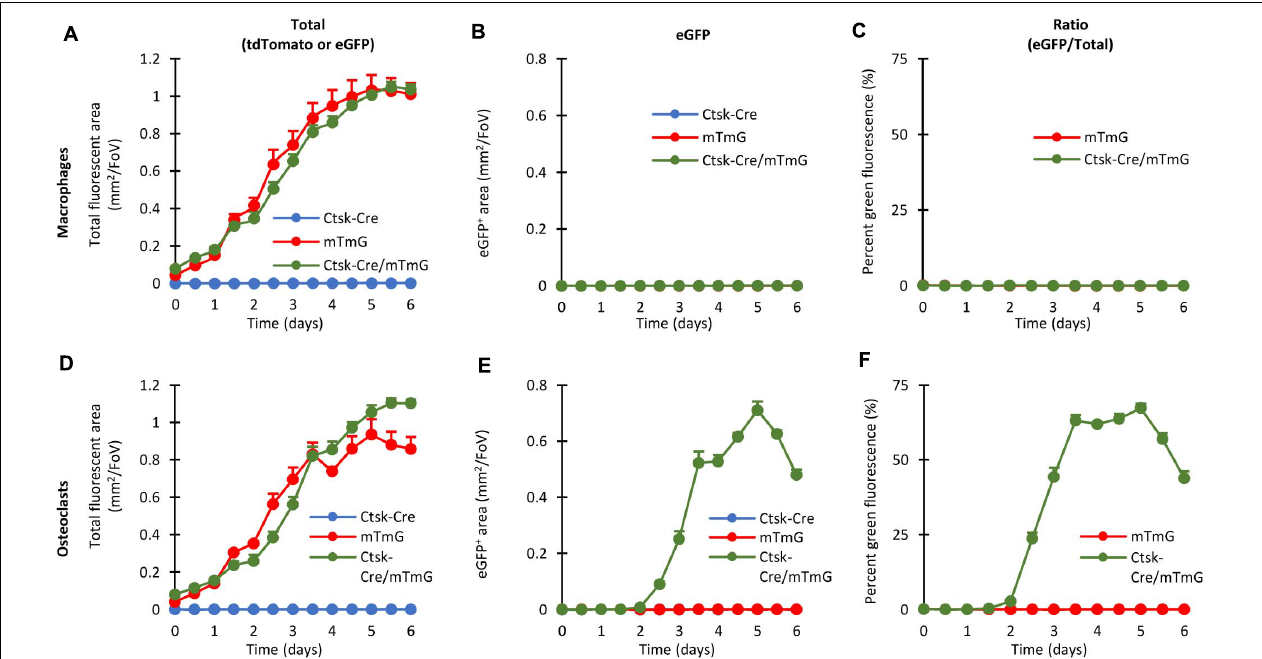
FIGURE 4 | Quantitative evaluation of the fluorescent signals in the FRAMCO1.1 assay. Quantification of the fluorescence signals of macrophage (A–C) or osteoclast (D–F) cultures of the indicated genotypes at the indicated time points. Graphs depict the kinetics of the total (tdTomato, eGFP or both) fluorescent area (A,D) , green (eGFP-positive) fluorescent area (B,E) and the ratio of the two areas (C,F) . All panels depict mean and SEM from 5 to 10 independent